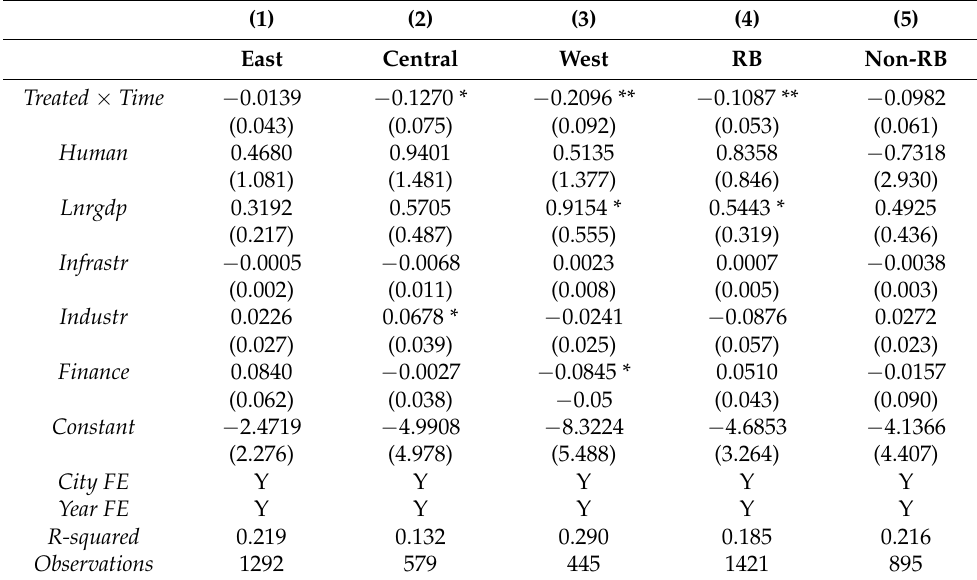
Table A2. Regional heterogeneity in